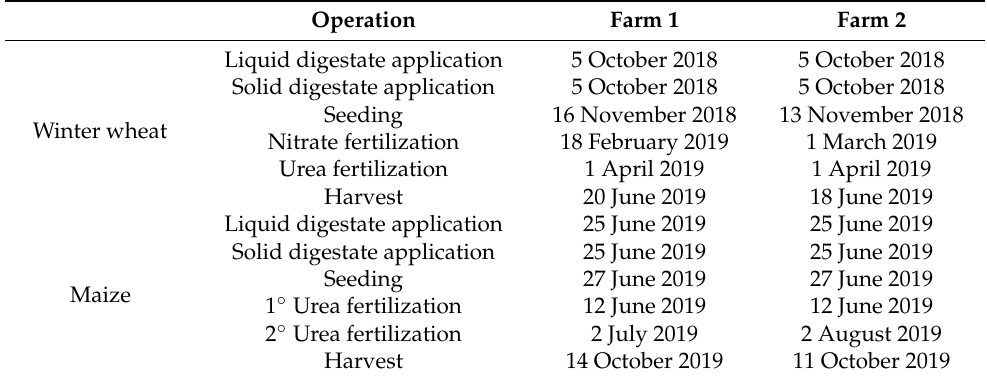
Table 2. Agronomic protocol of management systems for both silage winter wheat and silage maize.